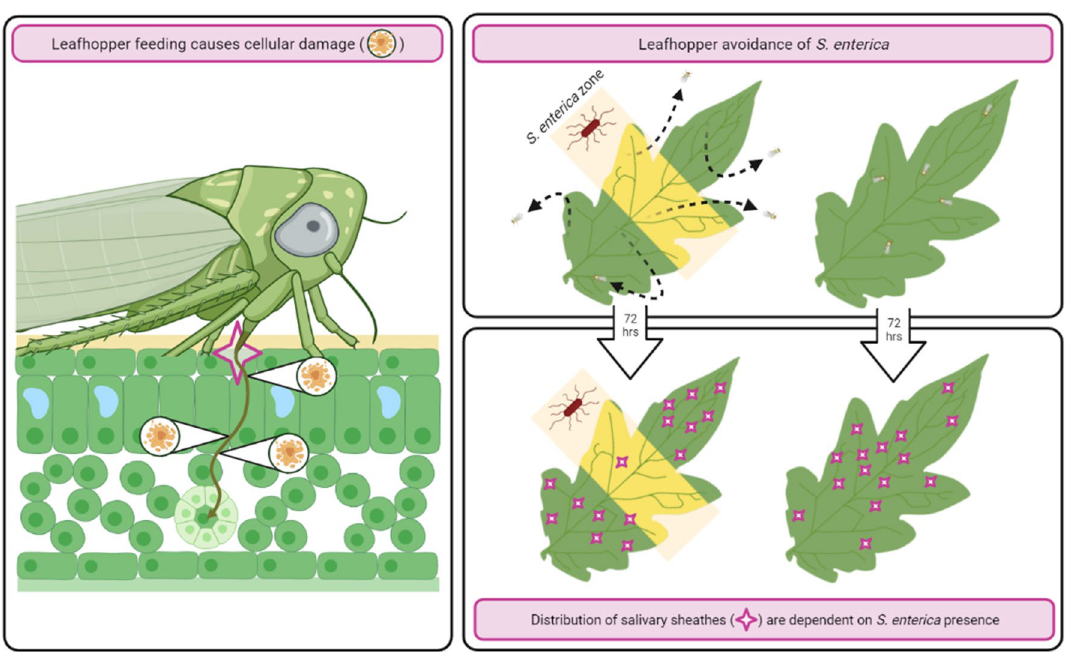
Figure 7. The presence of S. enterica alters M. quadrilineatus feeding behaviors. Infestation by M. quadrilineatus on S. enterica inoculated tomato plants resulted in significantly greater rates of localized cellular damage and bacterial populations than uninfested leaflets (left panel). Over a 48-h period of infestation, cohorts of M. quadrilineatus migrated away from tomato leaflets with partial, or entire, S. enterica inoculation (top). Cleaning and staining procedures 72-h afterwards demonstrated that zones of bacterial inoculation contained the least amount of salivary sheathes indicating an aversion to S. enterica within the phyllosphere (bottom). Image created through Biorender